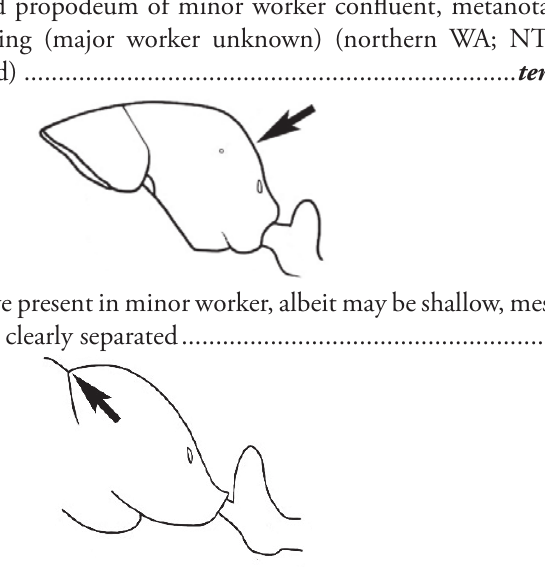
26 In profile, clypeus distinctly recurved at about midpoint, produced over mandible as small ledge; in full-face view, anterior margin of major and minor worker clypeus a broadly convex, sometimes crenulate curve that does not protrude over apical curve of mandible; in profile, dorsum of minor worker